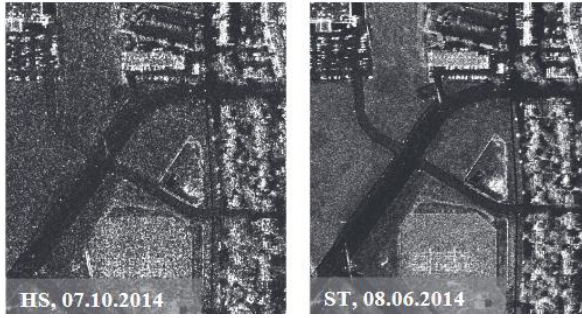
Figure 5. Comparison of a HS scene (left) with a ST scene (right).